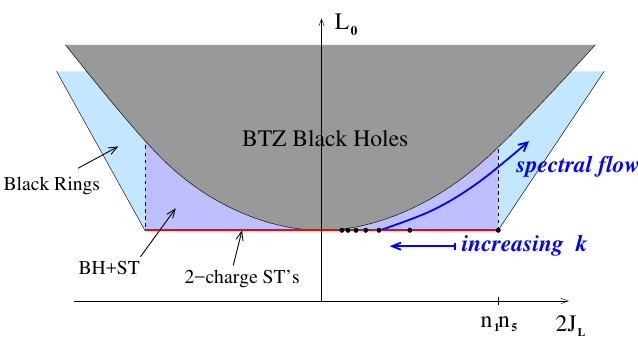
Figure 15. Two-charge supertubes are BPS con(cid:12)gurations at the lower bound in energy, and for angular momenta up to J = n 1 n 5 = 2. Between the unitarity bound and the BTZ threshold, there is a black hole plus supertube phase at low angular momentum (purple), and a black ring phase at high angular momentum (light blue). Spectral (cid:13)ow in the spacetime CFT takes one phase into the